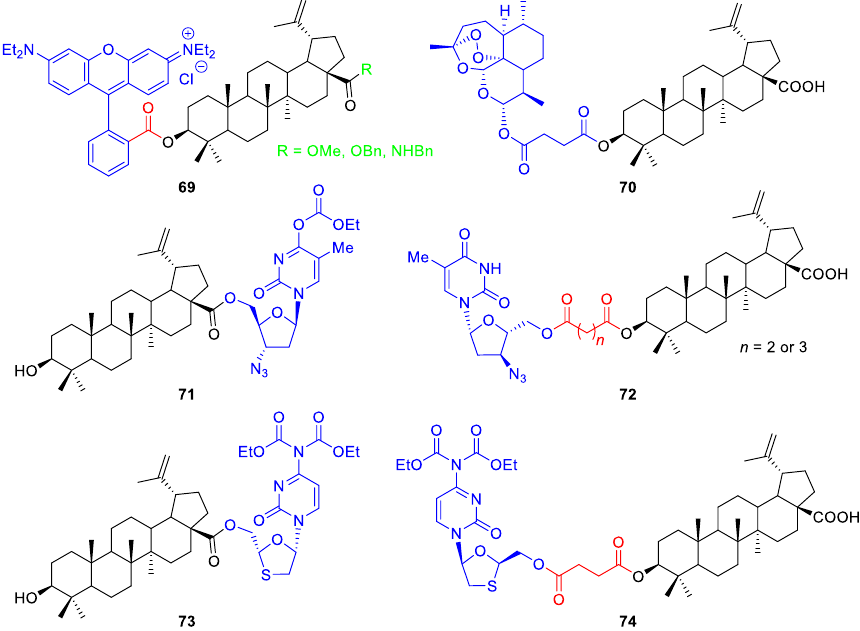
Figure 3. Chemical structures of BA esters derivatives bearing a rhodamine B moiety 69 , an artesunic acid unit 70 , and anti-HIV drugs 71 – 74 .